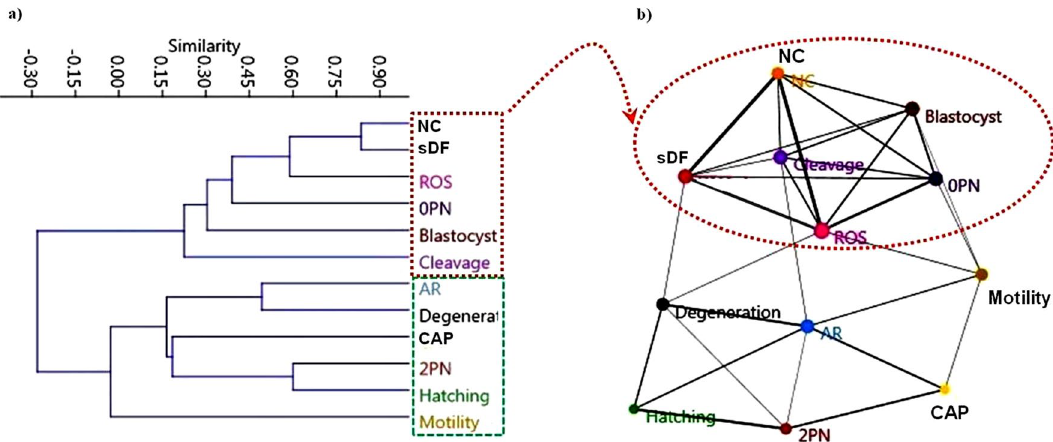
Figure 7. Study of hierarchical clustering (HCA) and network analysis. ( a ) The HCA analysis using the Pearson distance metric and un-weighted pair group method (UPGMA algorithm) was performed using PAST software to generate clustering patterns of sperm parameters, ROS production, and in vitro fertilization outcomes. Dashed color boxes (red and green) on the right side of the HCA show two distinct clusters. ( b ) Network analysis of the parameters of sperm and oocyte competence. All parameters are represented by circles of the network. Network analysis with visualization was performed by the PAST tool using the Fruchterman–Reingold algorithm as a force-directed layout algorithm. The Pearson correlation was chosen to determine the association between the edges and the nodes. The 50% threshold was the highest cut-off point in the visualization of the network in which there was no subsequent interaction between the variables. Nodes are parameters of sperm quality and oocyte competence. Edges represent the relationship between all variables. The size of the nodes and edges refers to the coefficient of clustering and the coefficient of correlation, respectively. Small nodes and thin edges indicate small values. Cluster and network analyses exhibited closeness between reactive oxygen species (ROS) production, cleavage rate, 0-PN rate, DNA fragmentation and blastocyst formation; red dashed box in part ( a ) and red dashed line in part ( b ). sDF sperm DNA fragmentation, NC non-capacitation, AR